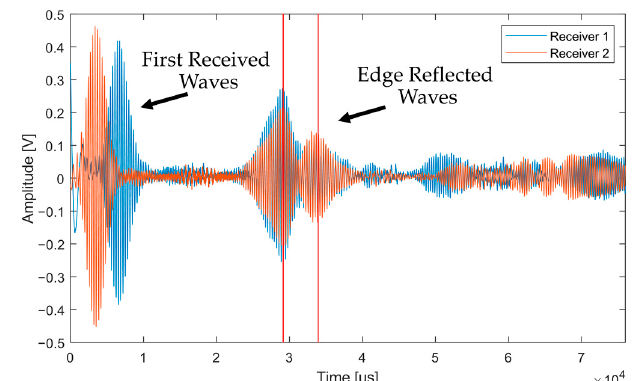
Figure 11. An example of a point on the plate where the direction of the signals could not be inferred due to the reflecting signals returning back to both receivers at the same time, as indicated by the red lines.